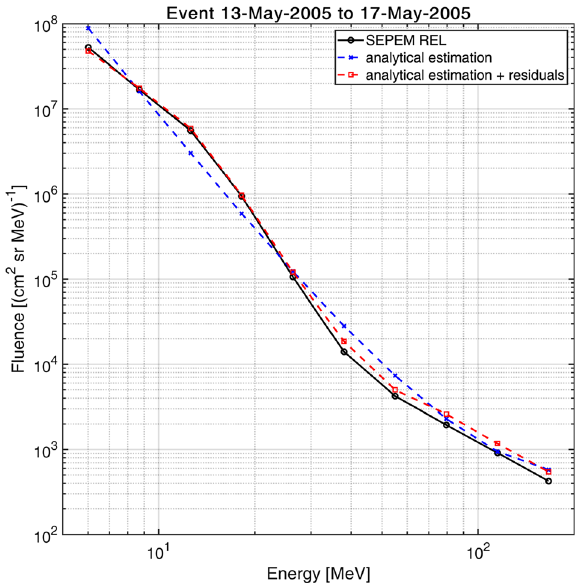
Fig. 9. Comparison of Fluence spectra, derived from data in black, calculated from the estimated spectral parameters in blue (analytical spectrum) and in red is the fi nal estimation which is the analytical spectrum adjusted with the estimated